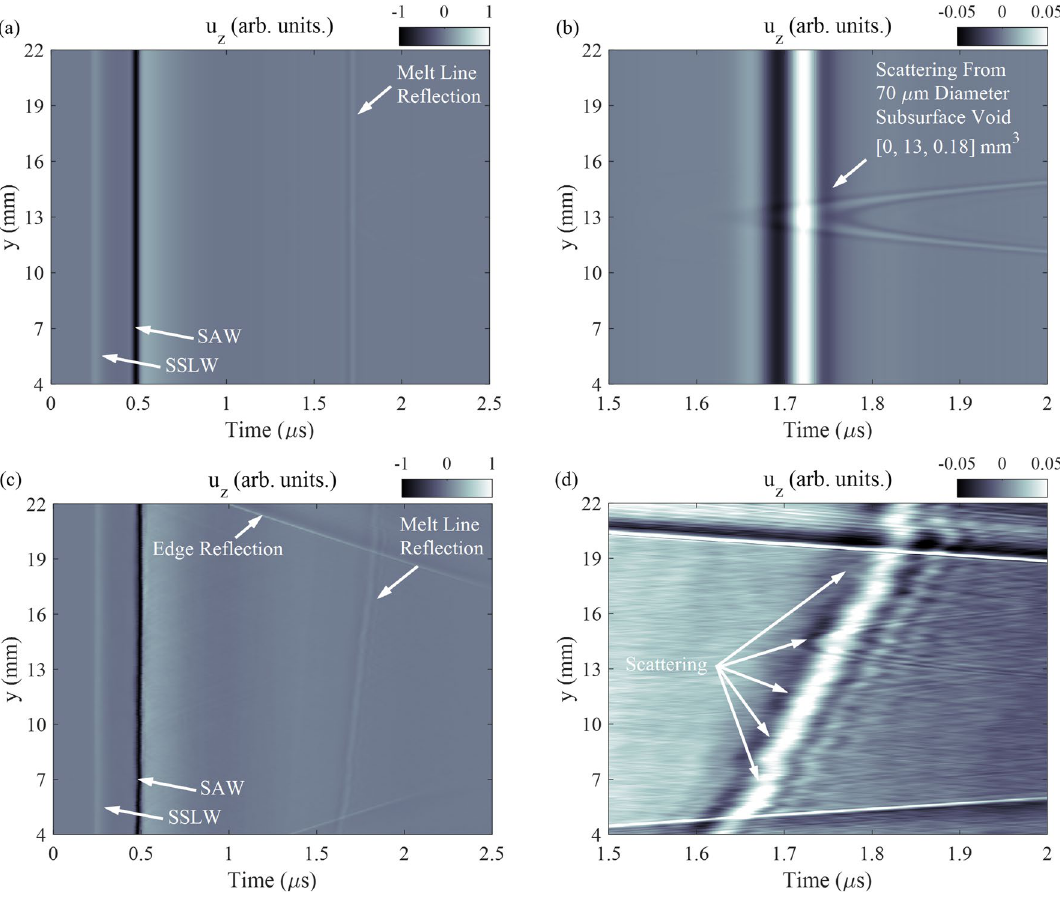
Figure 5. ( a ) Simulation of normal displacement while scanning along the y-axis of the sample. ( b ) Zoomed-in portion of the image in ( a ) showing planar scattering from the melt line and parabolic scattering from a 70 µ m diameter sub-surface void located at (0, 13, 0.18) mm 3 (x, y, z). ( c ) Experimentally measured displacement while scanning along the y-axis of the sample. ( d ) Zoomed-in portion of the image in ( c ) showing planar scattering from the melt line and scattering from multiple sub-surface